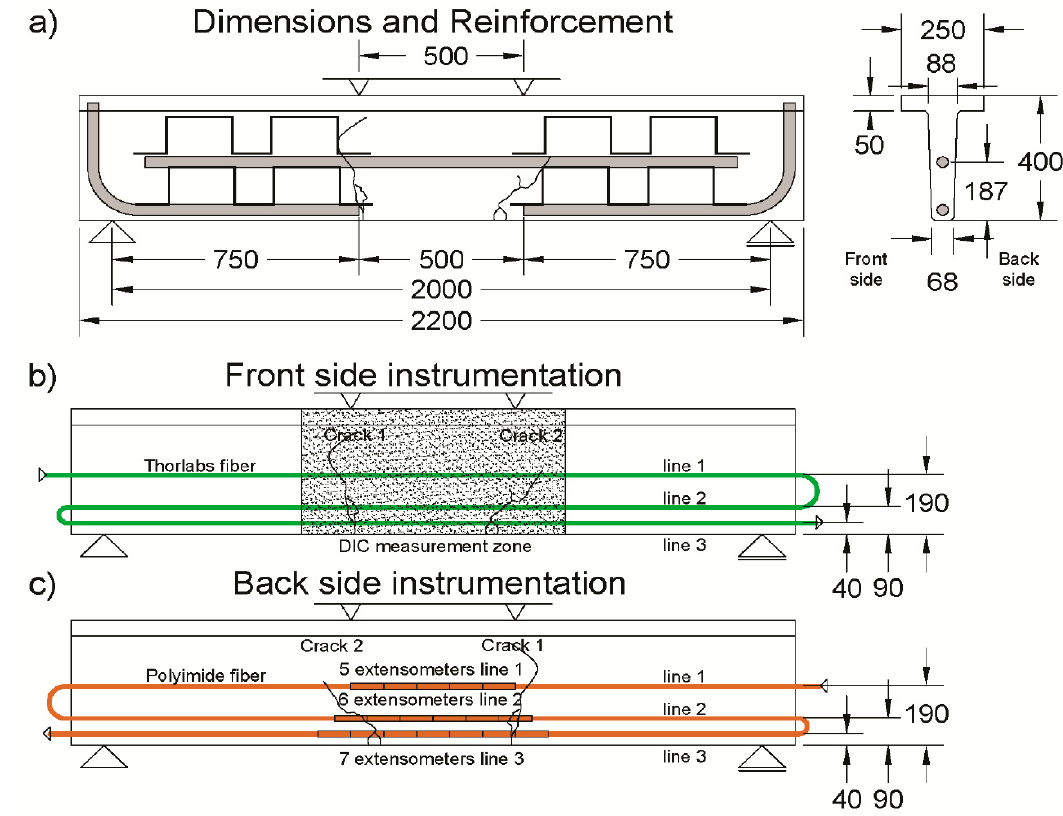
Figure 5. Scheme of test setup and instrumentation: ( a ) beam dimensions and reinforcement, ( b ) instrumentation on the front side and ( c ) instrumentation on the back side; dimensions in mm; the critical fictitious cracks 1 and 2 are marked.